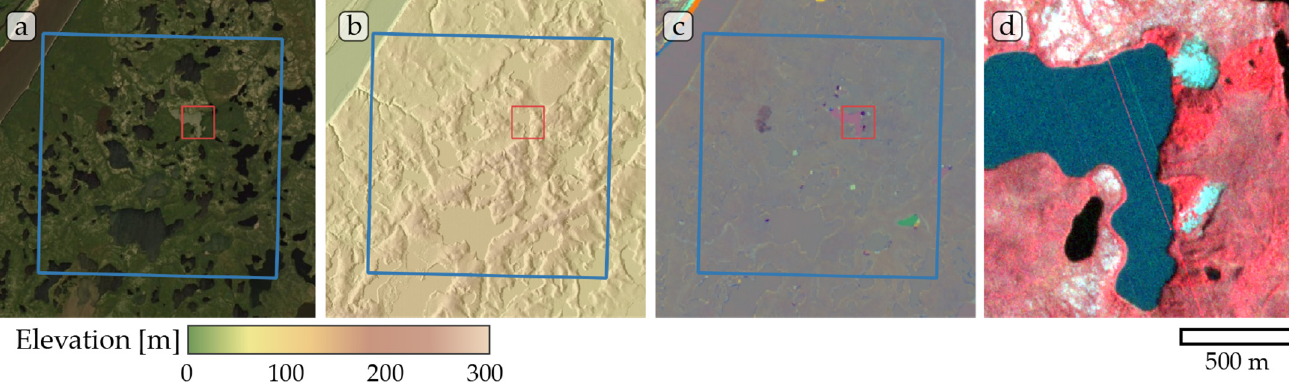
Figure A8. Study site Lena. ( a ) ESRI satellite layer, ( b ) ArcticDEM superimposed with hillshade, ( c ) Tasseled Cap trend visualization, ( d ) PlanetScope satellite image (NIR-R-G) acquired on 31 July 2019. Blue box, 10 × 10 km study site. Red box detailed view of ( d ).